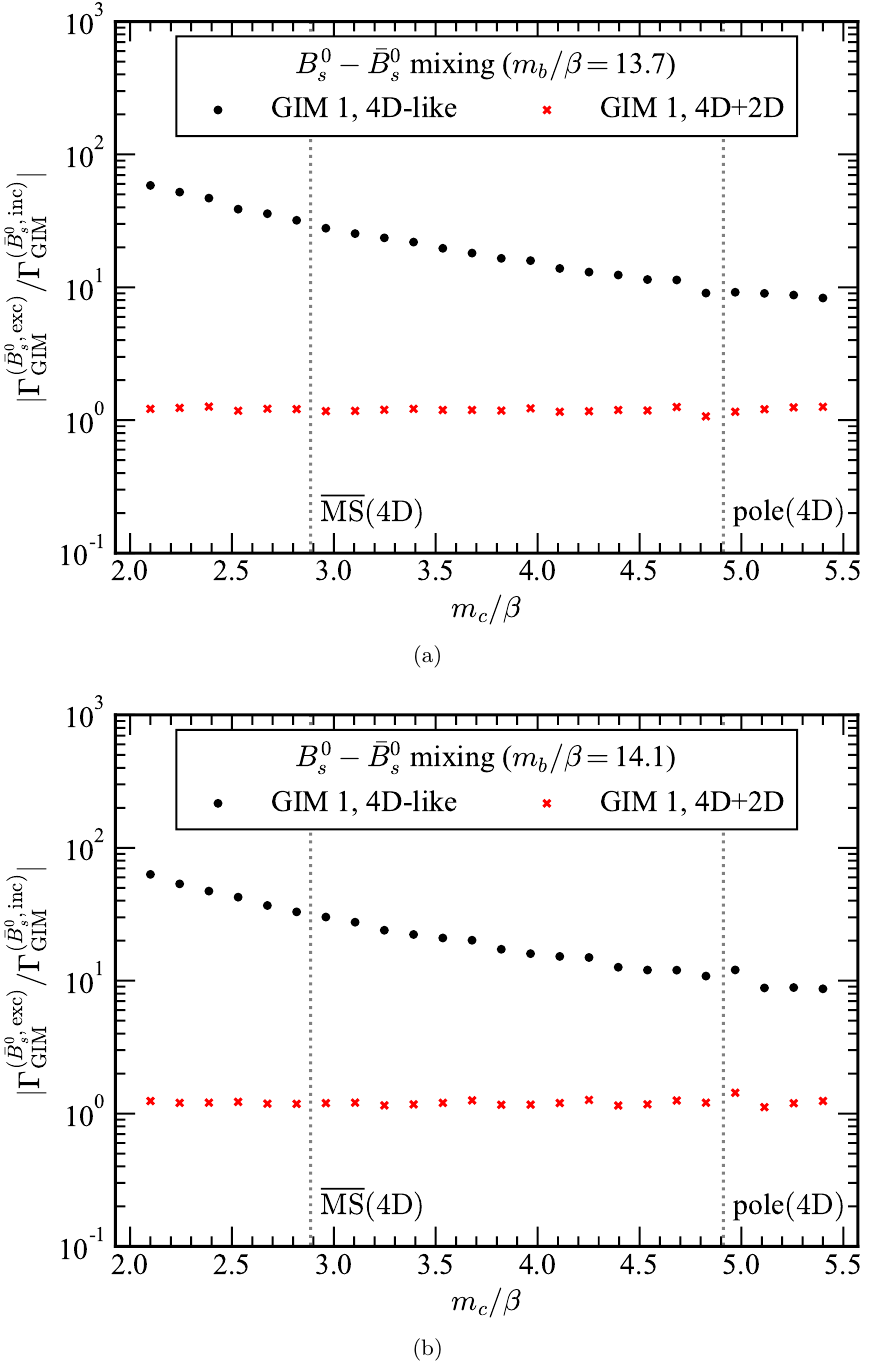
¯ mixing: (a) m − B 0 s s